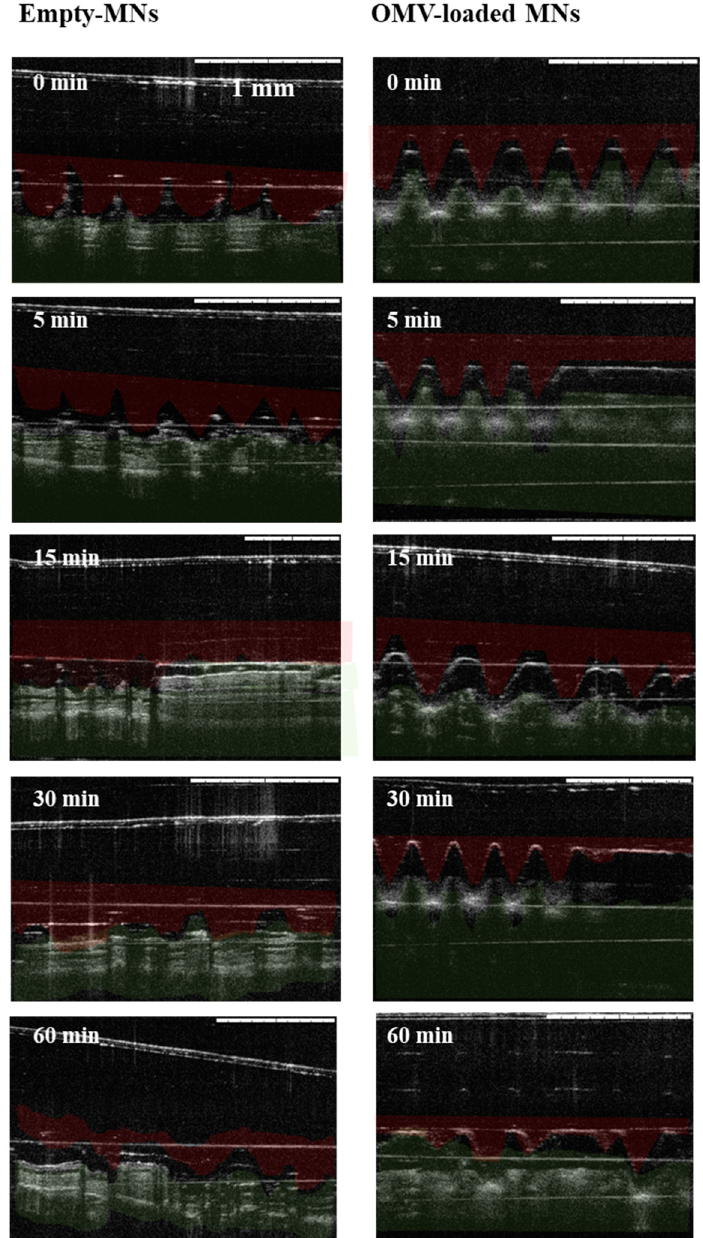
Figure 4. Optical coherence tomographic (OTC) images of dissolving empty or antigen-loaded MN in murine skin. Images show in vitro dissolution kinetics at 0, 5, 15, 30, and 60 min after insertion in murine ear. Red color represents needles and green color skin. Scale bars: 1 mm.